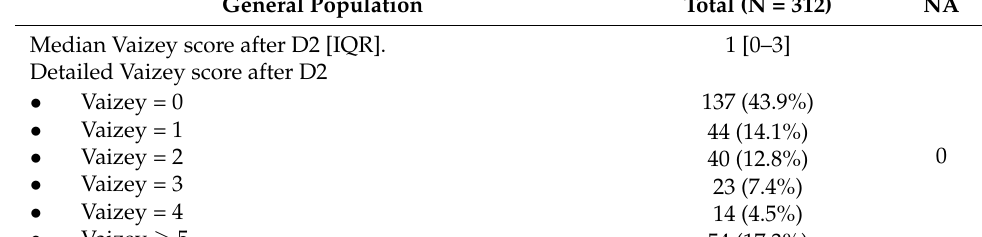
Table 3. Outcomes measured 6 months after D2. General Population Total (N = 312) NA Median Vaizey score after D2 [IQR]. 1